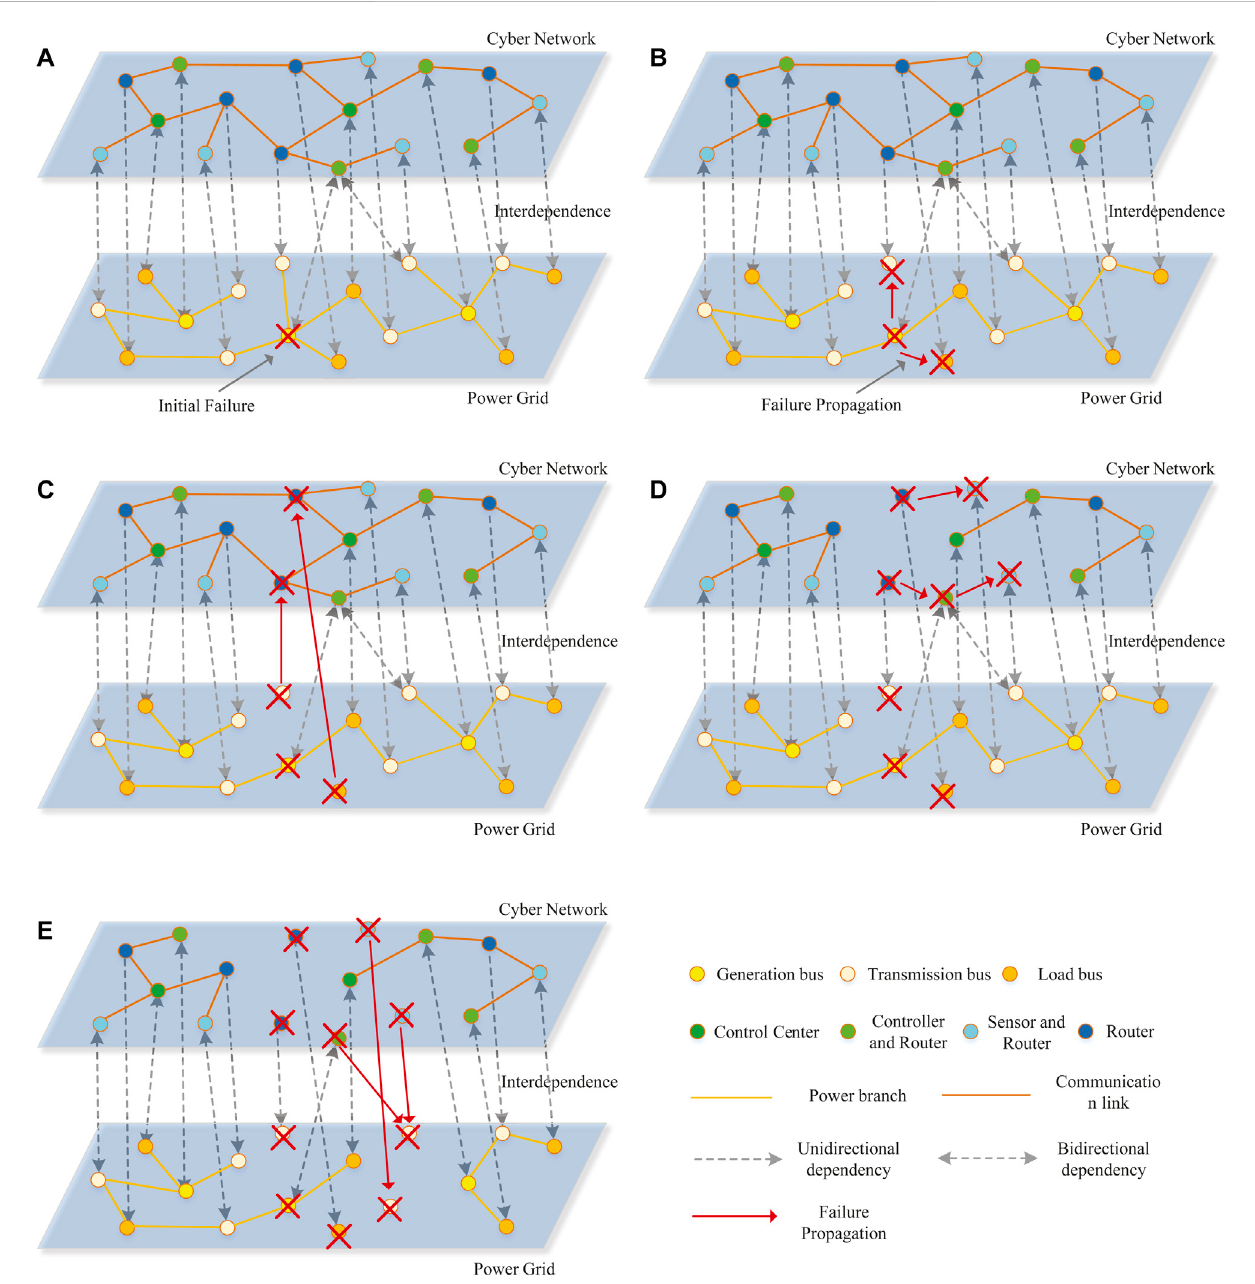
FIGURE 2 Failure propagation in interdependent CPPS. (A) Example CPPS model with interdependency. (B) Failure propagation in the power grid due to an initial failureinthepowergrid,i.e.,intra-domainfailureinthepowergrid. (C) Power-dependentcybernetworkfailure,i.e.,inter-domainfailureinthecybernetwork. (D) Failure propagation in the cyber network due to its own failure, i.e., intra-domain failure in the cyber network. (E) Cyber-dependent power grid failure, i.e., inter-domain failure in the power